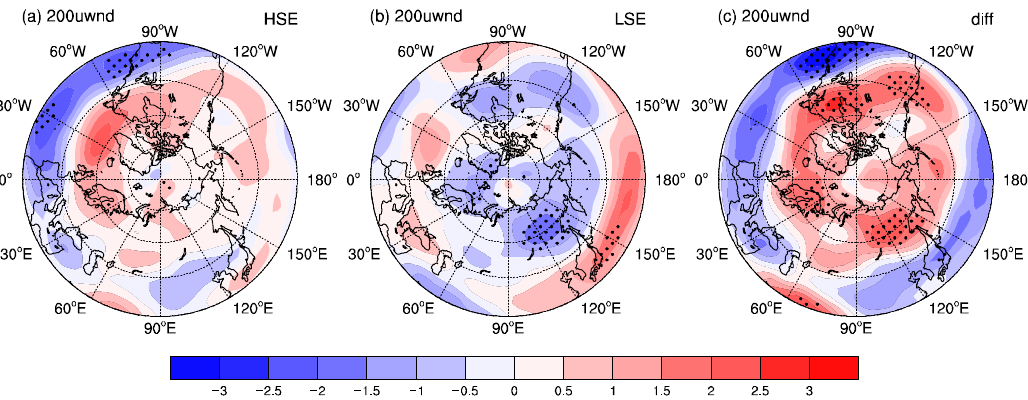
Figure 7. Composite differences in 200-hPa horizontal winds (units: m s − 1 ) for the composite of more HSE years and more LSE years in wintertime over NEC: ( a ) anomalies in the composite of more HSE years; ( b ) anomalies in the composite of more LSE years; ( c ) differences between the composite of more HSE years and that of more LSE years. Stippling denotes where the anomalies are significant at the 90% confidence level.